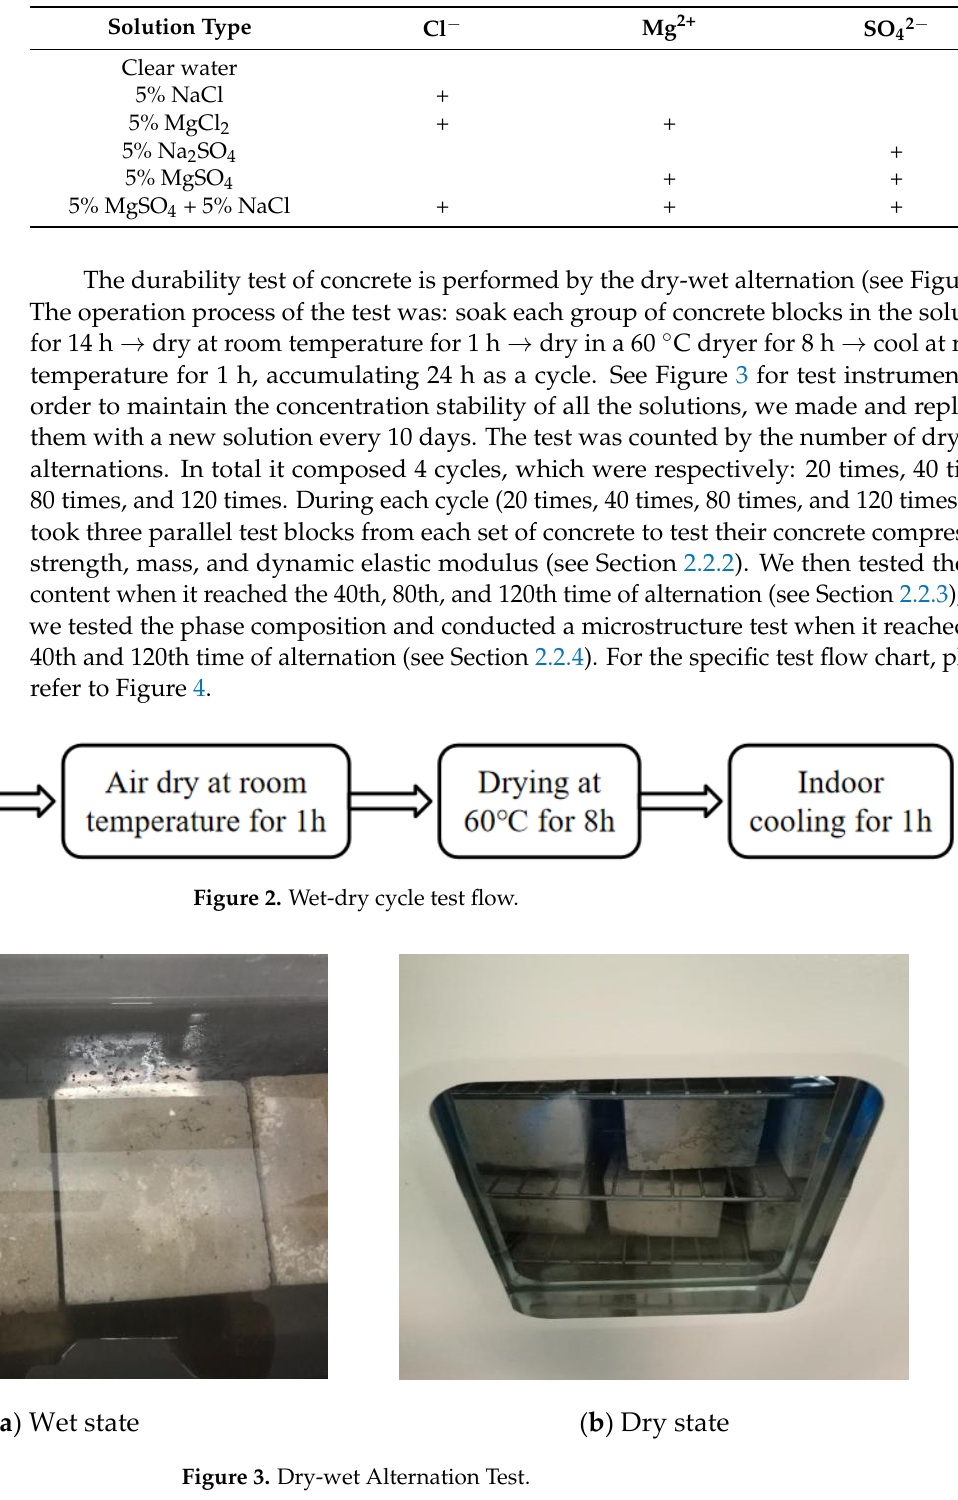
Table 3. Types and Ionic Compositions of Corrosion Solutions.